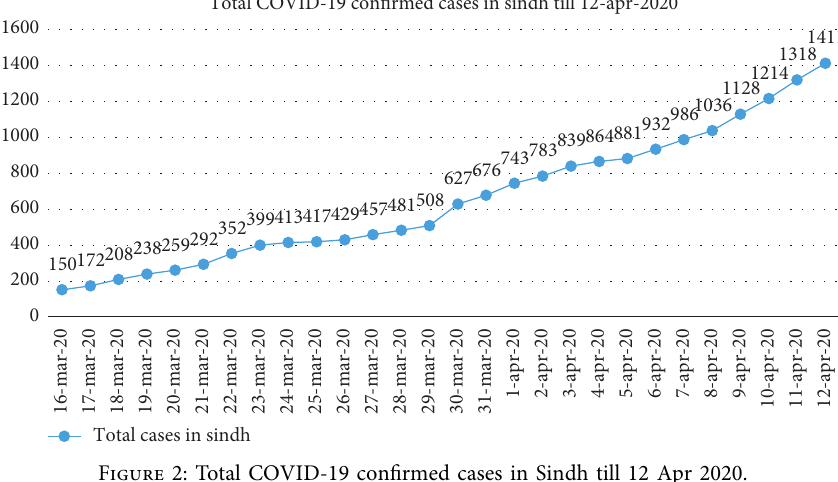
Figure 2: Total COVID-19 confirmed cases in Sindh till 12 Apr 2020.